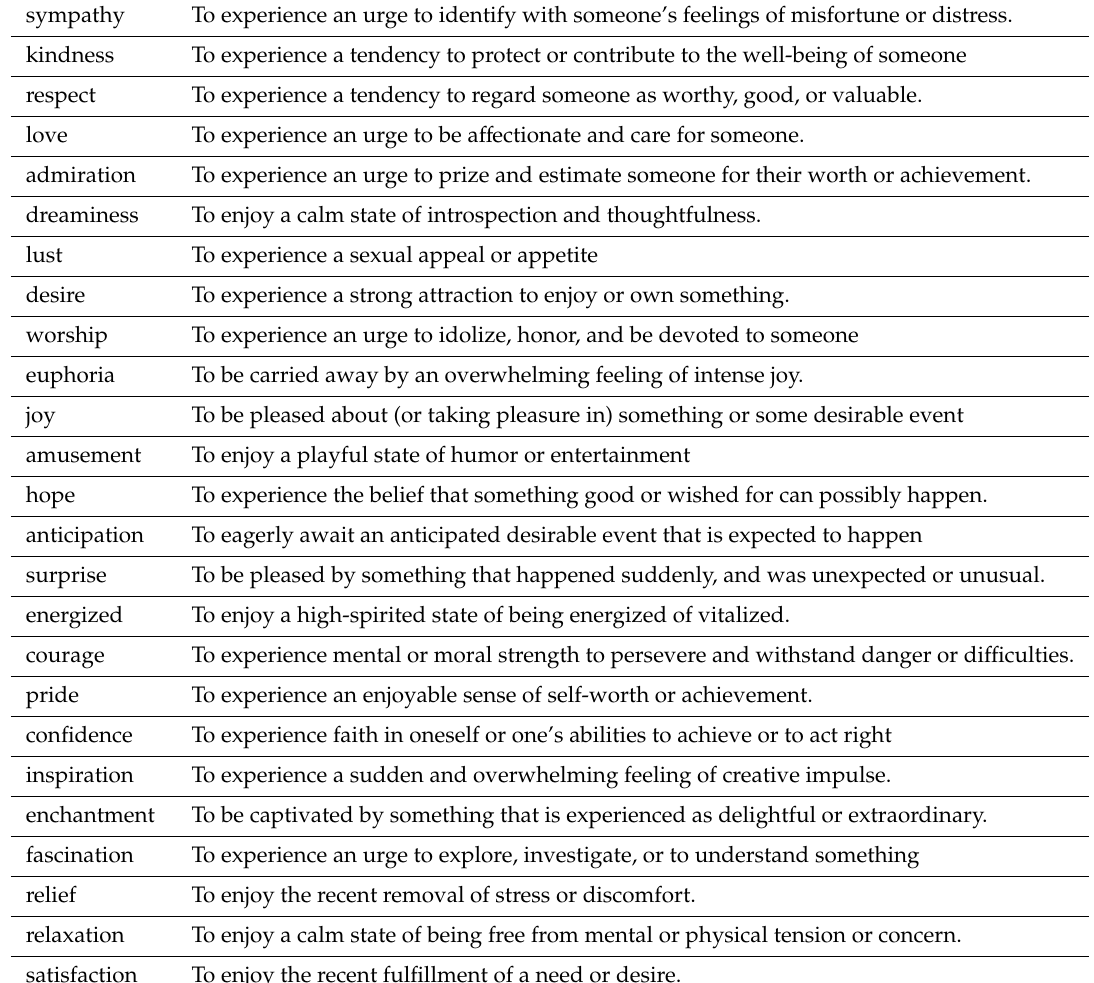
Table 3. Twenty five positive emotions in human-product interaction [16] (p.